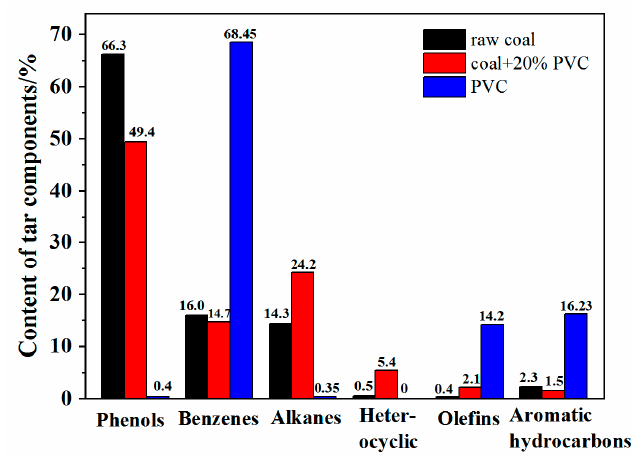
Figure 5. The content of pyrolysis tar components.